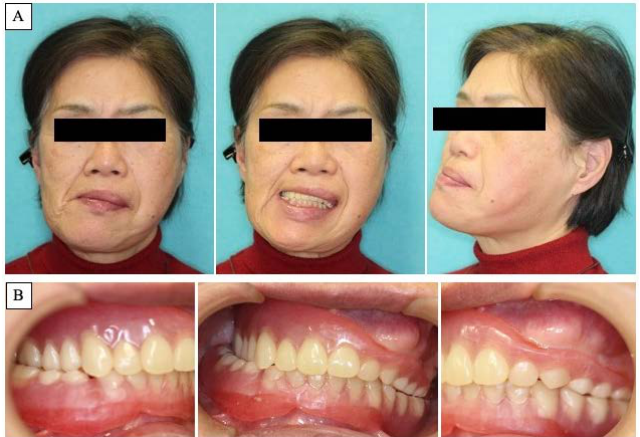
Figure 1. Clinical features at first visit. ( A ): Horizontal inclination of the maxillary occlusal plane and facial asymmetry with right-sided deviation of the mandibular midline. ( B ): Denture with crossbite arrangement at the right side.